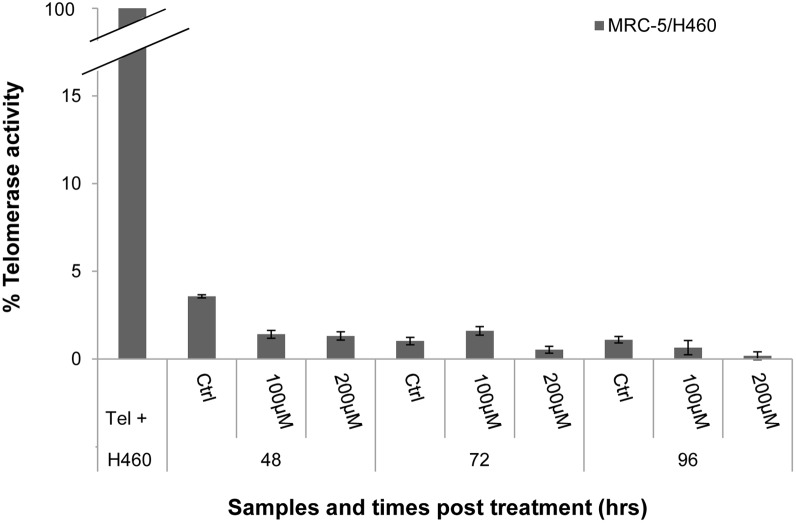
RTQ-PCR TRAP assay.The graph displays data on telomerase activity. Data were normalised to the control value represented by the tumour cell line H460, which is considered to have 100% telomerase activity. Our samples yielded values definitively less than 5%, indicating no telomerase activity in our samples at different doses and times post treatment. The error bars were calculated using standard error propagation rules. p>0.05 by Student’s t-test.